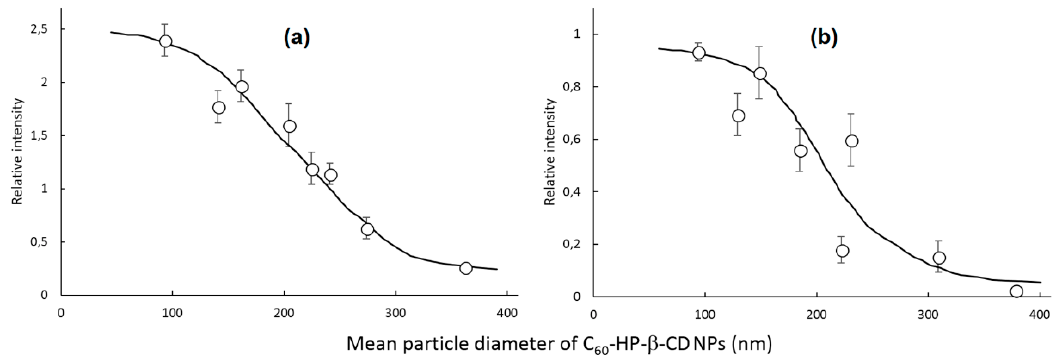
Figure 69. Particle size dependencies of C 60 for the generation of ( a ) HO• and ( b ) 1 O 2 after visible light irradiation supplied from a fluorescence lamp (3500 lux, λ = 400–700 nm, 2 cm from the bottom) for 15 min. Each point represents the mean ± S.E. of three to five experiments. Adapted from Iohara; Hiratsuka; Hirayama; Takeshita; Motoyama; Arima; Uekama [218].